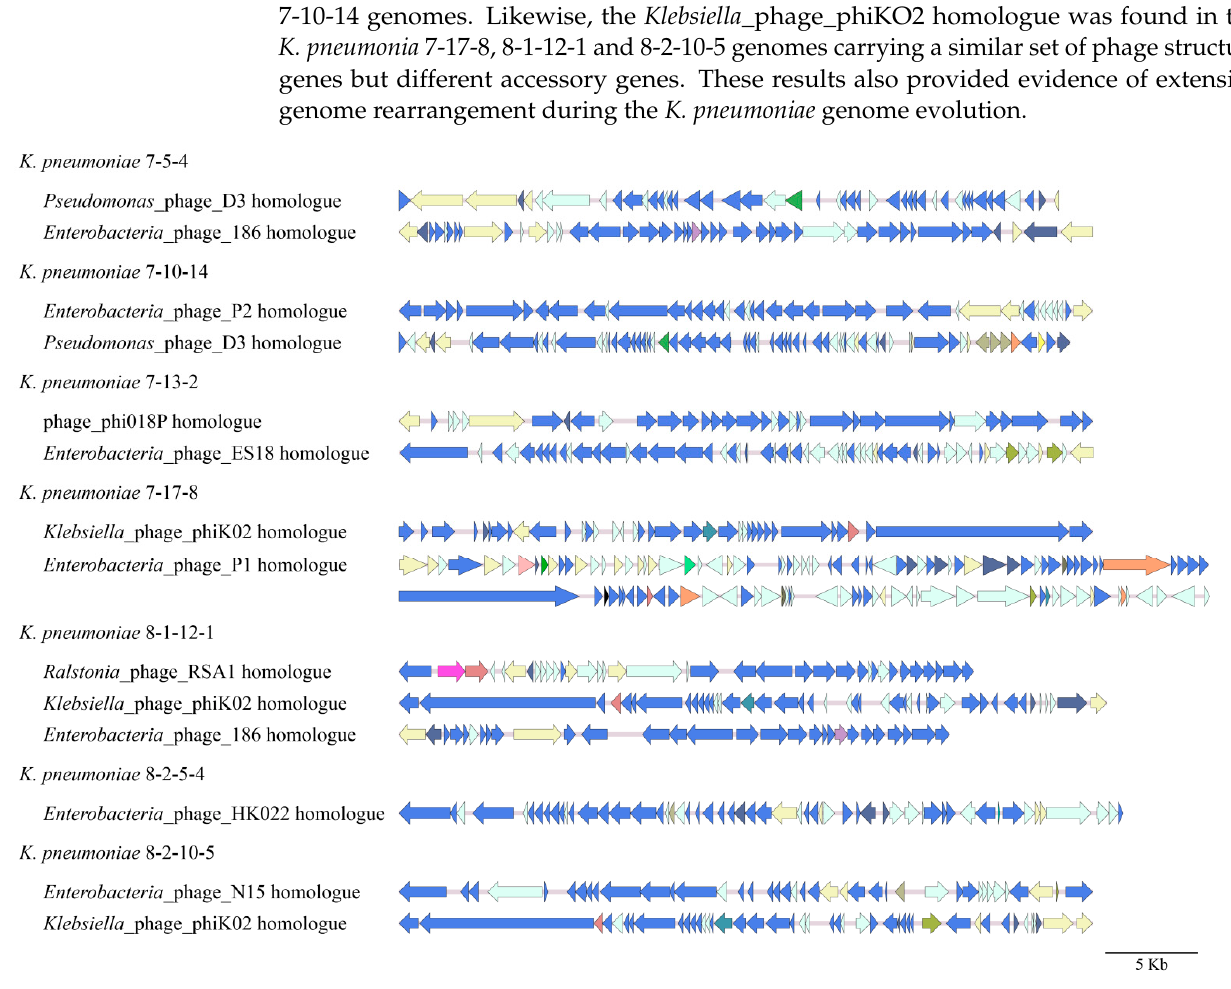
Figure 4. Gene organizations of the prophages identified in the K. pneumoniae genomes.